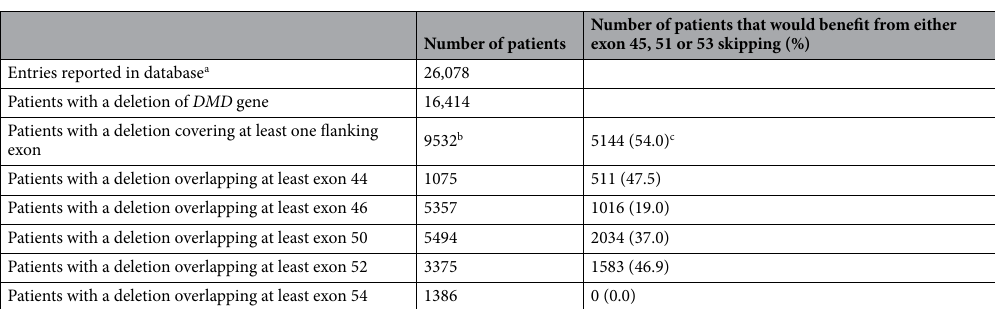
Table 1. Number of patients reported in LOVD-DMD database, and proportion of these patients that would be rescuable by either exon-51, exon-53 or exon-45 skipping. a LOVD-DMD database accessed on April 20 th 2020. b The numbers of patients with a deletion of at least one flanking exon corresponds to the number of DMD patients reported in LOVD-DMD database that would be identified by our assay. c Of the 9532 DMD patients identified by our assay, 5144 would benefit from either exon 51, 53 or 45 skipping.